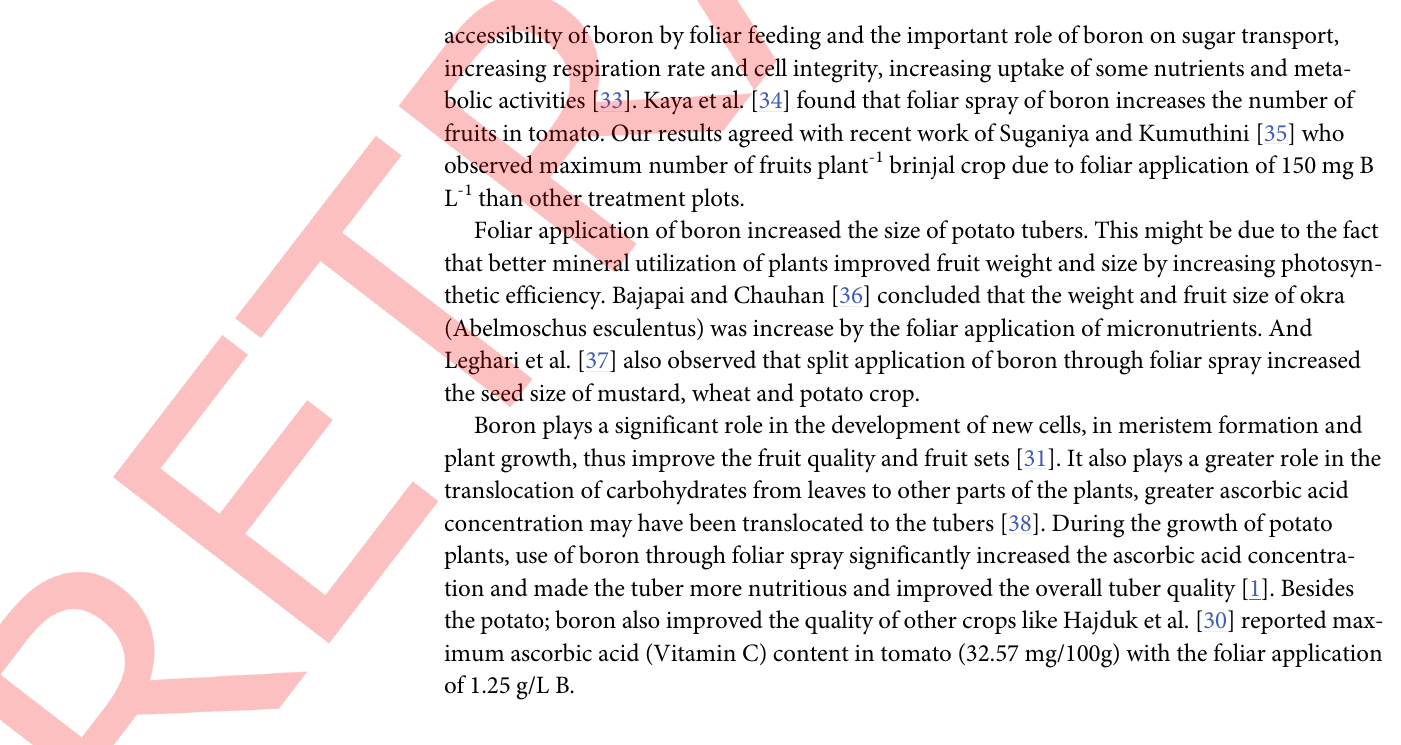
Fig 3. Relationship between moisture loss and boron concentration in potato tuber.